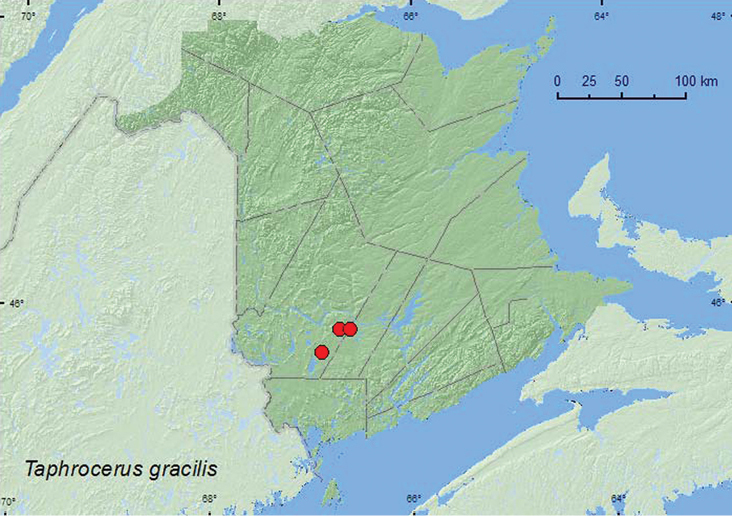
Collection localities in New Brunswick, Canada of Taphrocerus gracilis.